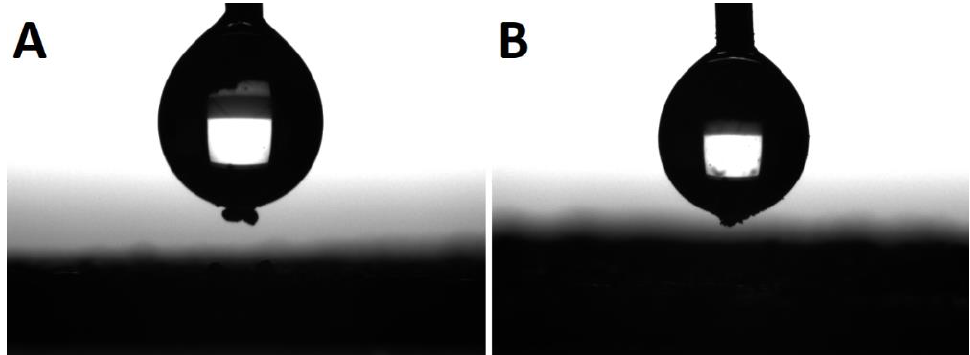
Figure 7. Water droplets during sessile drop analysis. Particles of modified TiO 2 visible on the bottom of each droplet after an attempt at placing the droplet on the pigment surface. ( A )—TiO 2 -1.5% i BuTMOS; ( B )—TiO 2 -1.5% i Bu 7